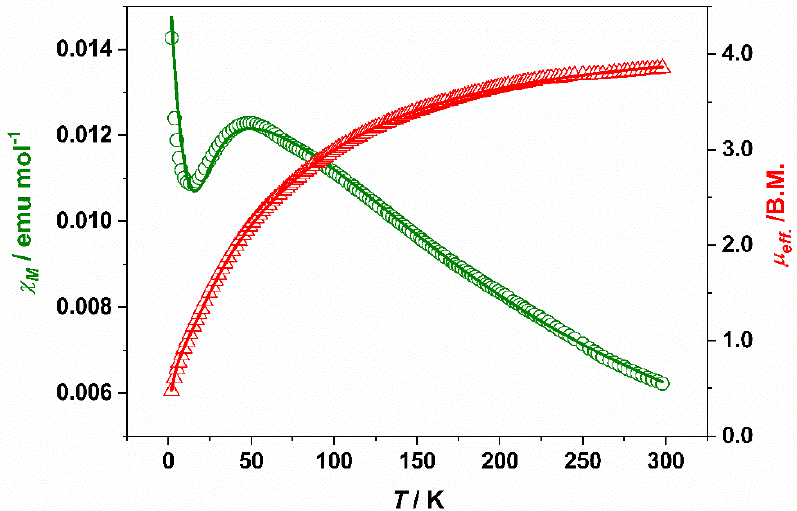
Figure 5. Temperature dependence of the molar susceptibility (o) and magnetic moment ( ∆ ) for compound [Ru 2 Cl( µ -O 2 CC 6 H 4 - o -OMe) 4 ] n ( 1a ). Solid lines are the product of a least-square fit of the experimental data to the model indicated in the text and considering compound 1b as the impurity.